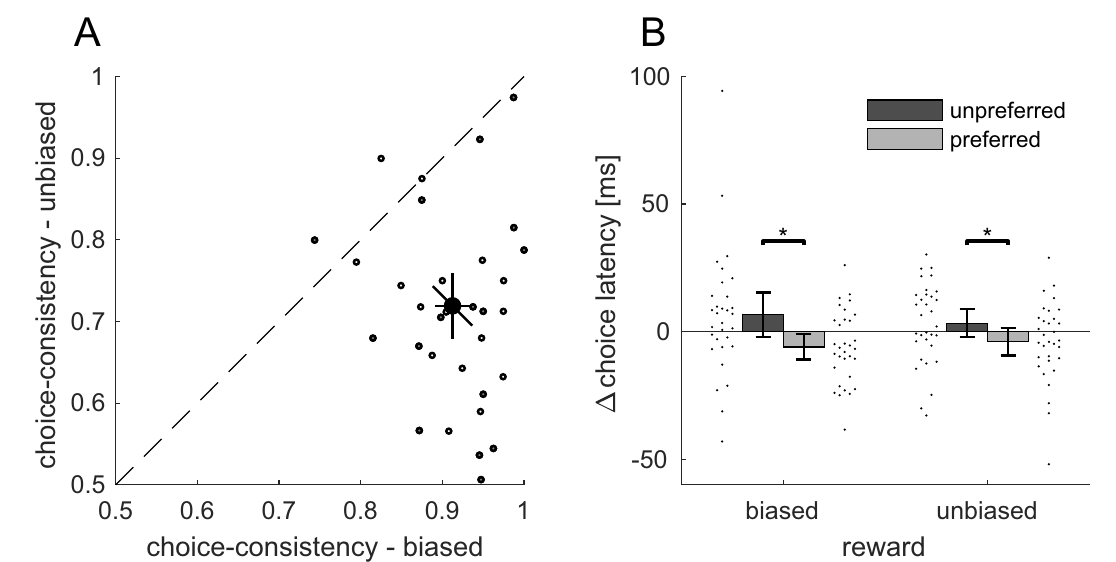
Fig 2. Choice behavior. (A) Choice-consistency expressed as proportion preferred target chosen for the biased and the unbiased reward condition. Open and grey-filled circles denote participants who started with the unbiased and biased condition respectively. The black symbol indicates the mean choice-consistency across all participants. The diagonal error bar denotes the variability of the difference between the two measures and has to be compared against the dashed diagonal. (B) Biased and unbiased choice-trial latencies split in preferred (light) and unpreferred (dark) targets. Data are plotted as the difference to the individual mean. All error bars denote 95% confidence intervals. Black data points next to each bar graph denote values of individual participants in that respective condition. Asterisks indicate a significant difference (p <